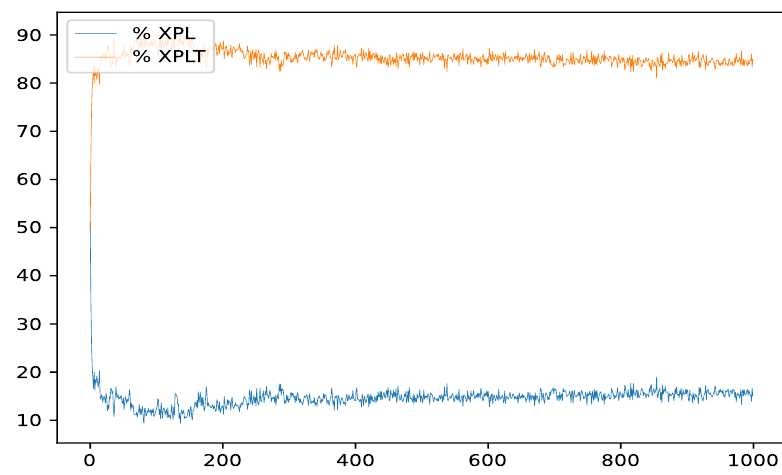
Figure 18. GWO-BCL-b5 Dimensional